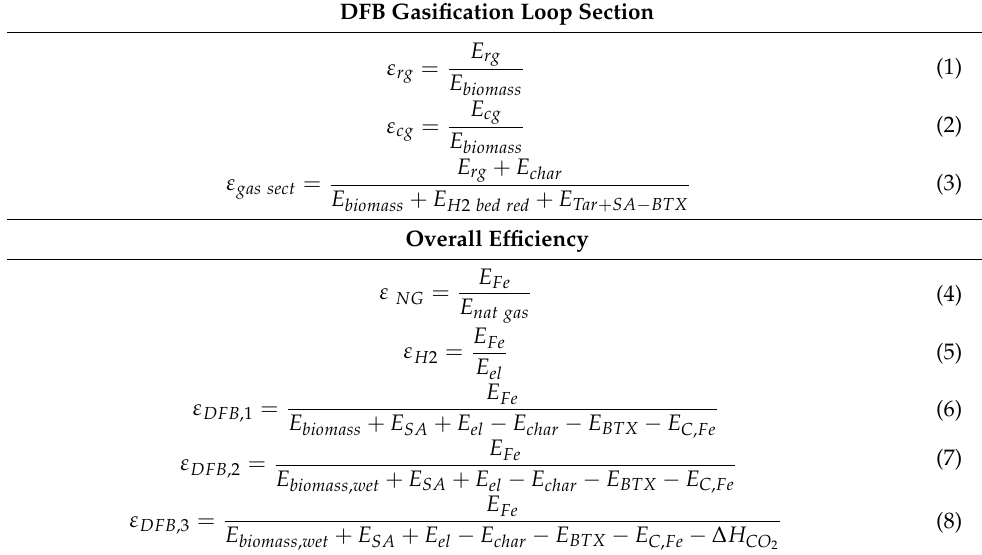
Table 3. Definitions of the efficiency performance indicators. All the efficiencies are based on chemical and electrical energies, i.e., the sensible and latent heat terms are not part of these definitions, except for ε DFB ,3 , which includes the sensible heat demand for reboiling the MEA. Subscripts are defined in Table